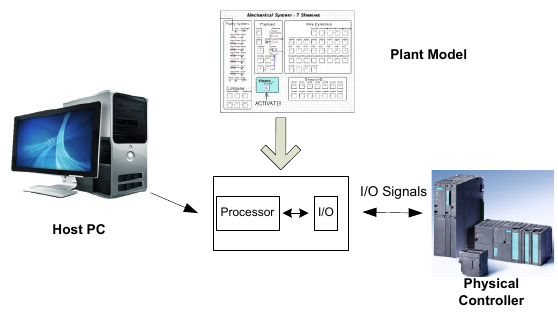
Fig. 1 Principle of HIL simulation. Figure 1. Principle of HIL